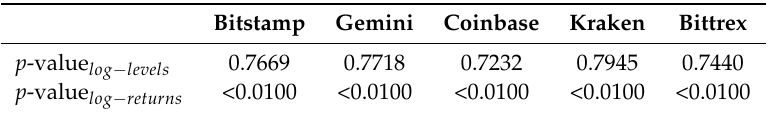
Table 4. Augmented Dickey–Fuller